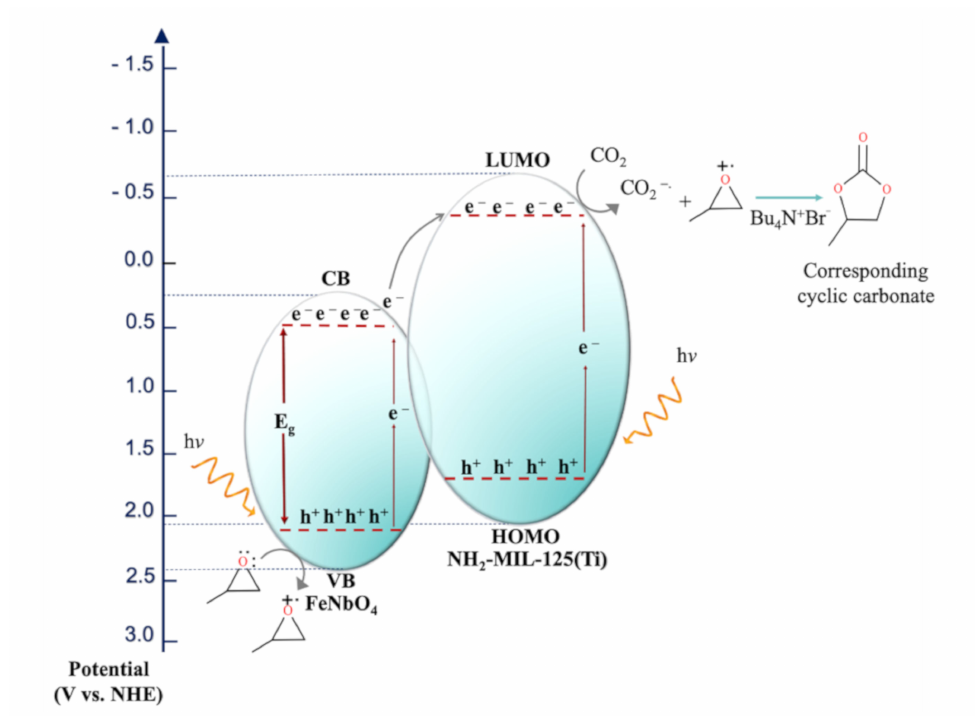
Figure 8. Proposed mechanism of FeNbO 4 /NH 2 -MIL-125(Ti) for the photocatalytic addition of CO 2 into propylene oxide. Table 3. Reaction conditions and results of NH 2 -MIL-125(Ti), FeNbO 4 and their composites (a) .